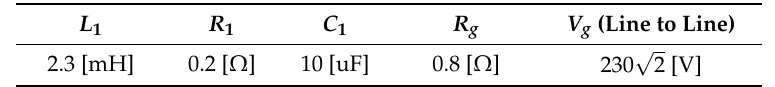
Table 1. System Parameters.